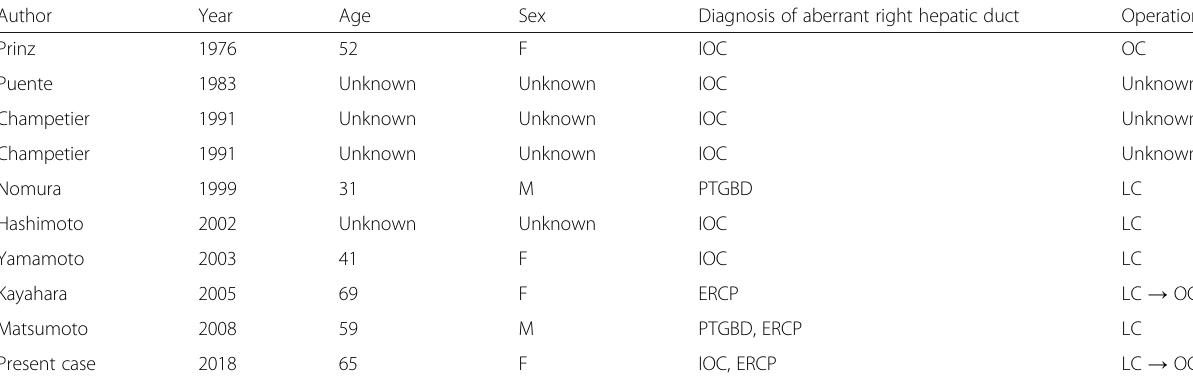
Table 1 Previous reports of the main right hepatic duct entering the cystic